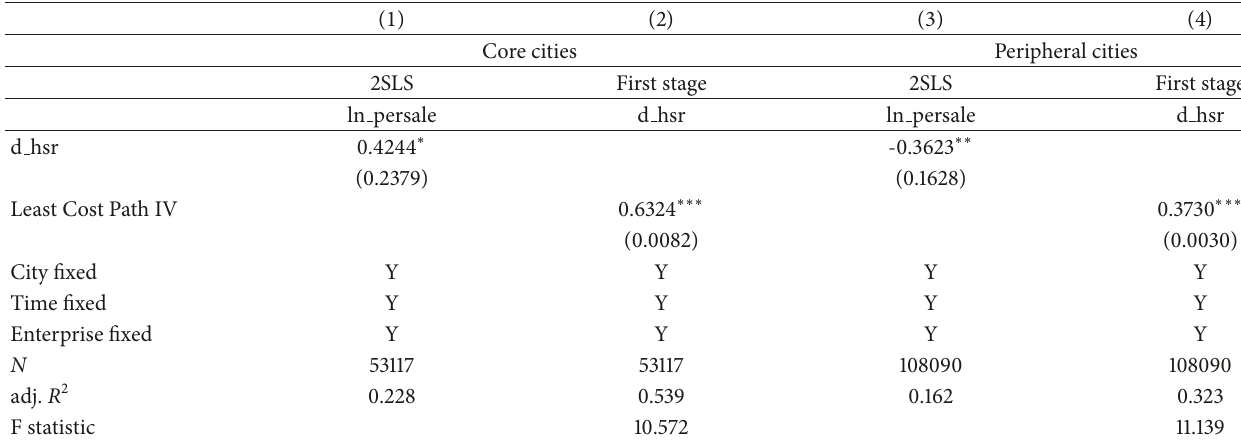
Table 6: Regression results of instrumental